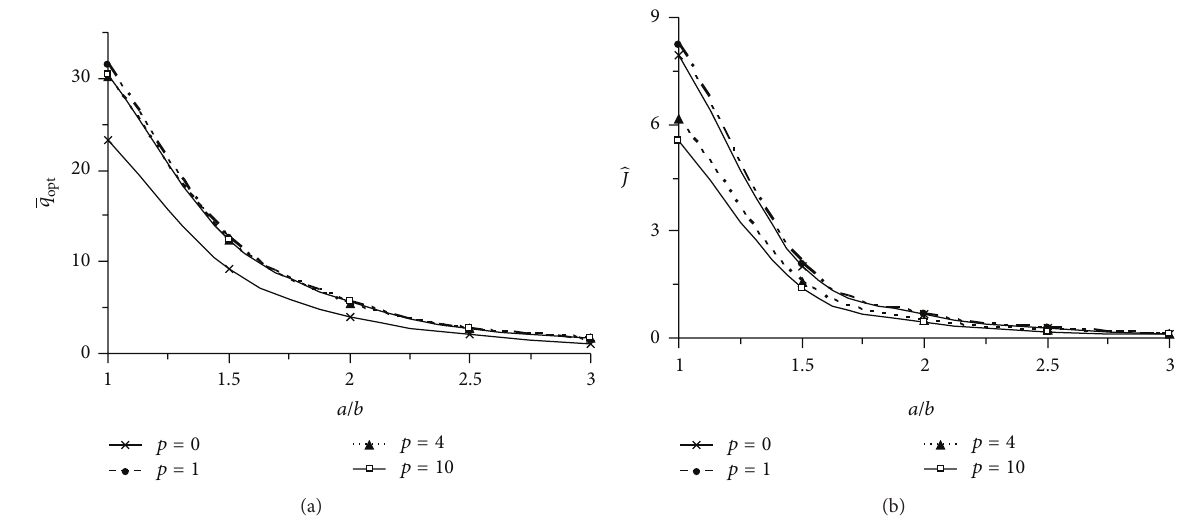
̂𝐽 , (b) for the energy , with ℎ = 0.02 m, 𝑟 = 10 . opt